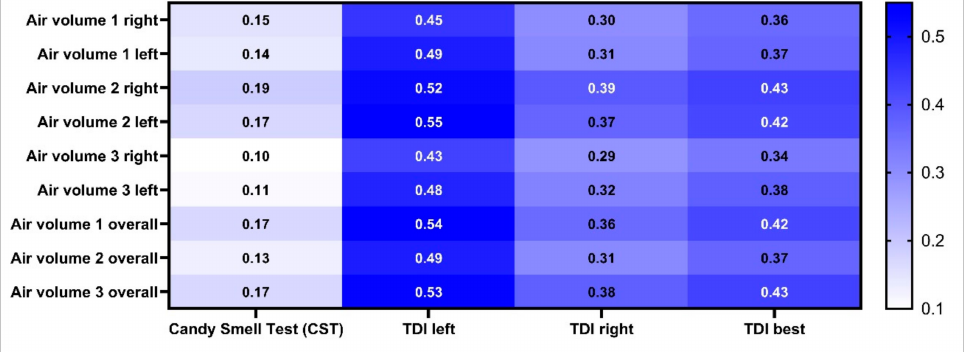
Figure 5. Correlation matrix between olfactory test results and olfactory cleft (OC)-air volume. The number represents Pearson’s r. Air volume 1 = the caudal boundary of the OC was defined at 1 cm inferior to the cranial boundary. Air volume 2 = the caudal boundary of the OC was defined at the lower border of the superior turbinate. Air volume 3 = the caudal boundary of the OC was defined at the head of the middle turbinate. TDI left = orthonasal olfactory function of the left nostril. TDI right = orthonasal olfactory function of the right nostril. TDI best = birhinal orthonasal olfactory